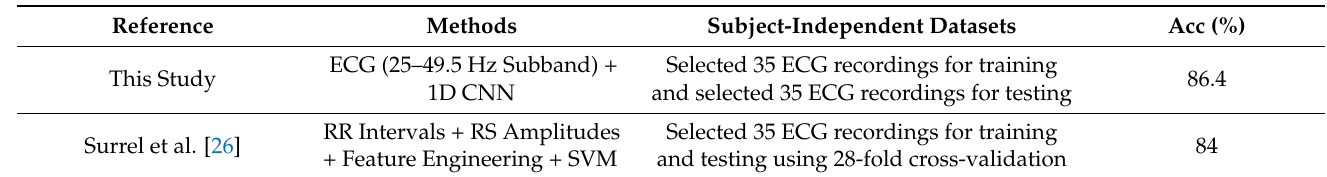
Table 6. Comparison of the method and performance of the proposed 1D CNN model with the previous study for the per-minute apnea detection using subject-independent datasets from MIT PhysioNet Apnea-ECG